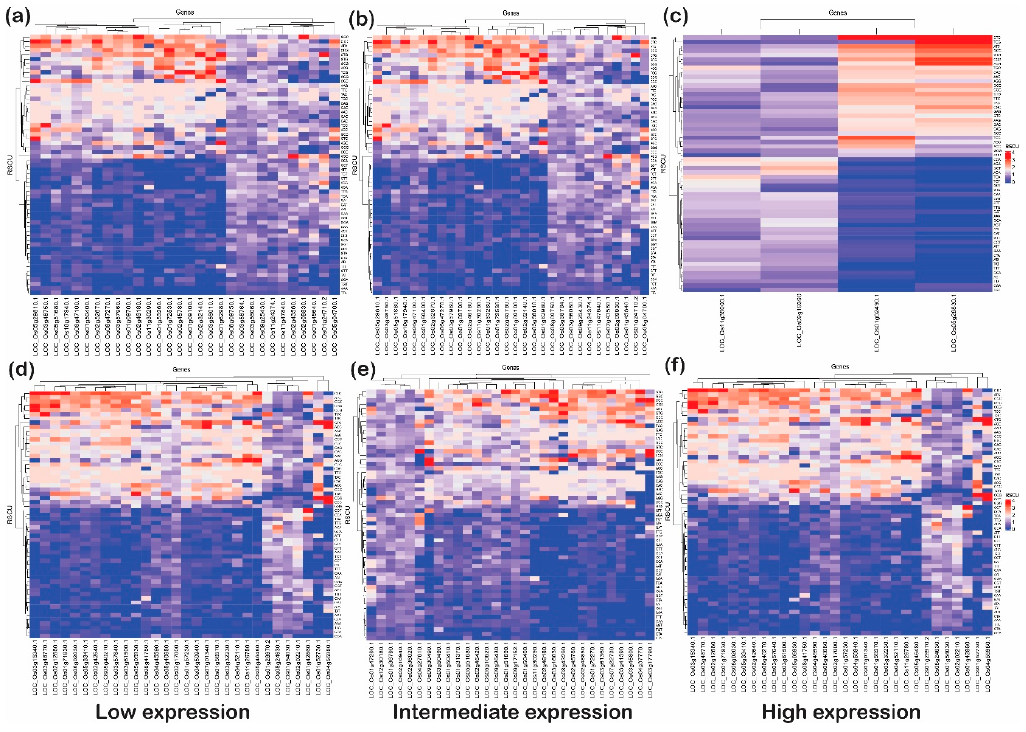
Figure 9. The heat plots of codon usage bias (CUB) under biotic stress. The codon usage bias in the genes expressed under ( a ) low, ( b ) intermediate and ( c ) high gene expression categories for downregulated genes and CUB profile for ( d ) low-, ( e ) intermediate- and ( f ) high-expressed genes for upregulated genes under abiotic stress condition in rice based on RSCU. The codons with AT at the third codon position are less biased than the codons with GC at the third nucleotide position. Table 2. Catalog of potentially beneficial replacement targets for synonymous change in rice genes. Table 3. Genes expressed under biotic and abiotic stress conditions with uniform usage of